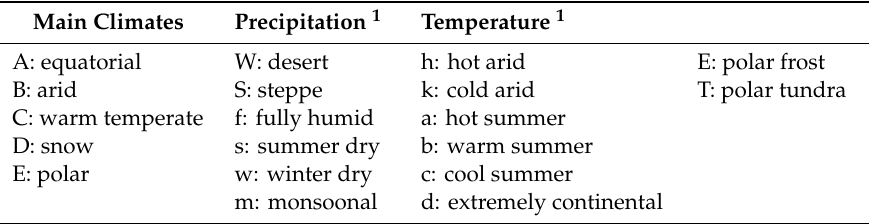
Table 1. Köppen–Geiger (KG) climate classification